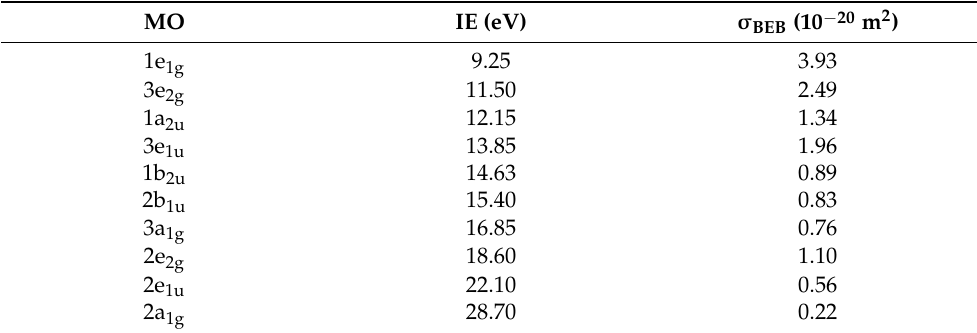
Table 1. Ionization cross sections for the outermost MOs of benzene as calculated with the BEB method. The input is available online